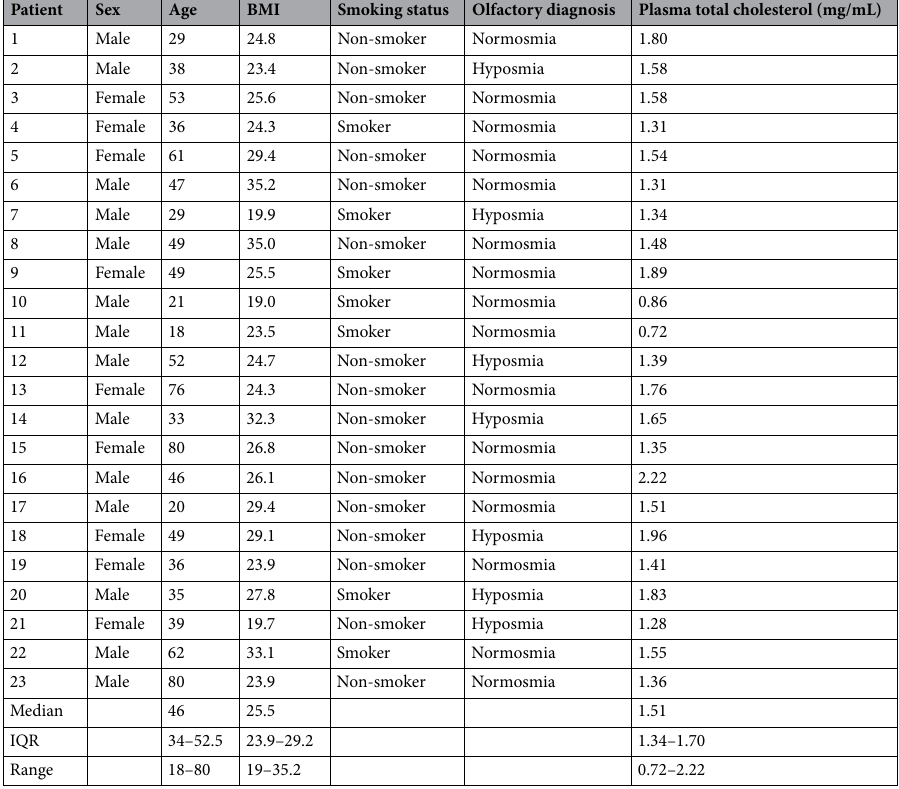
Table 1. Individual characteristics of human donors. BMI body mass index, IQR interquartile range